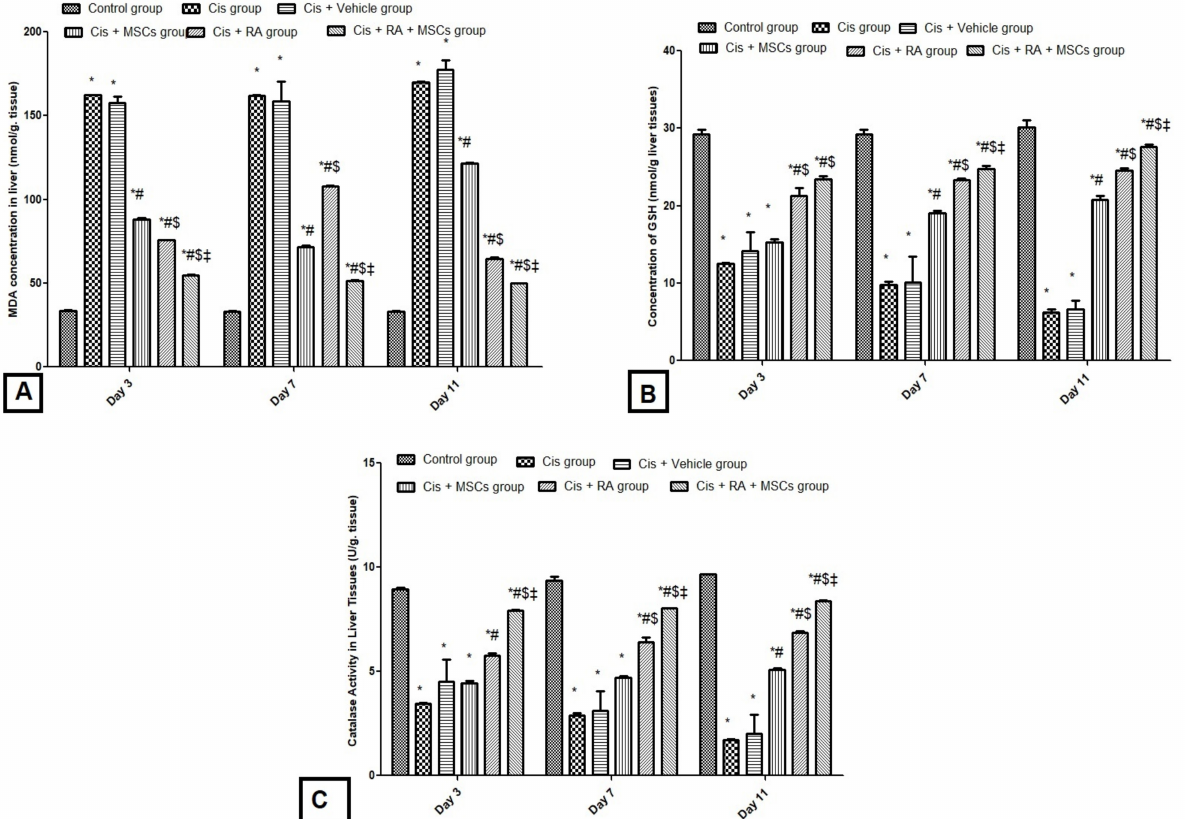
Figure 3. Markers of oxidative stress including MDA ( A ), GSH ( B ) and catalase ( C ) in different studied groups. All data are expressed as mean ± SD. One-way ANOVA with Tukey pos thoc test. * Significant vs. control group, # significant vs. Cis group, ‡ significant vs. Cis + BM-MSCs group and $ significant vs. Cis + RA group. MDA = malondialdehyde and GSH = glutathione, CAT = catalase, Cis = cisplatin, RA = retinoic acid and BM-MSCs = bone marrow derived mesenchymal stem cells. p < 0.05 is considered